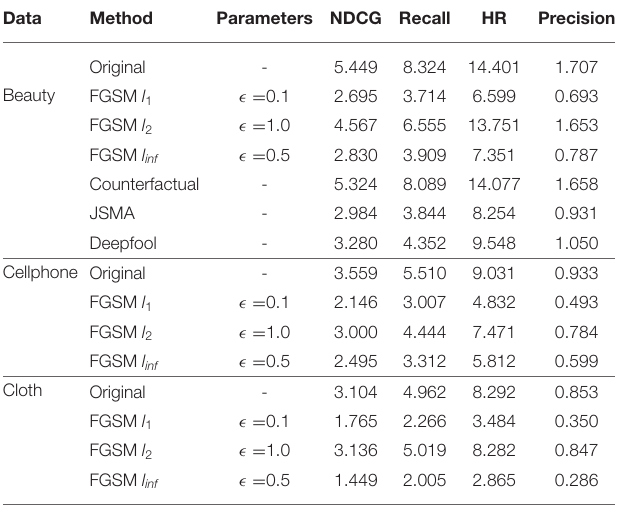
TABLE 1 | Adversarial attack results on Amazon Beauty, Cellphone, and Clothing. Data